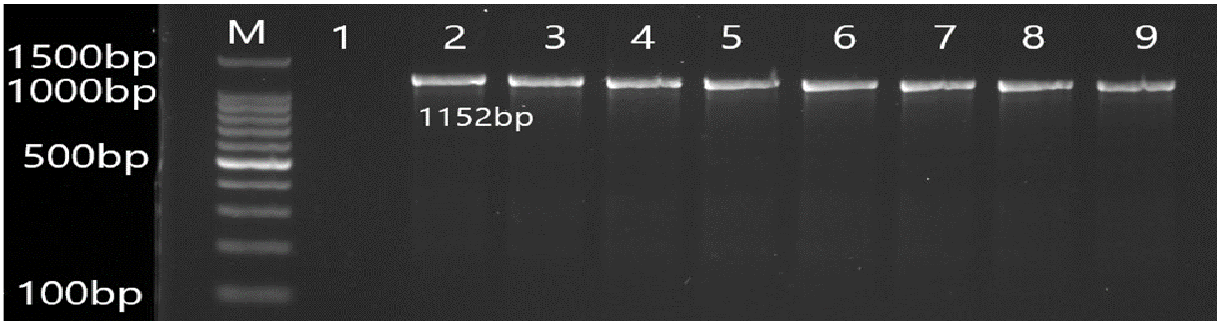
Figure 6. Electrophoresis showing amplicons of P. aeruginosa oprM gene. Lane M: 100 bp molecular marker, Lane 1: Negative control, Lane 2 – 9: Positive isolates of oprM gene.